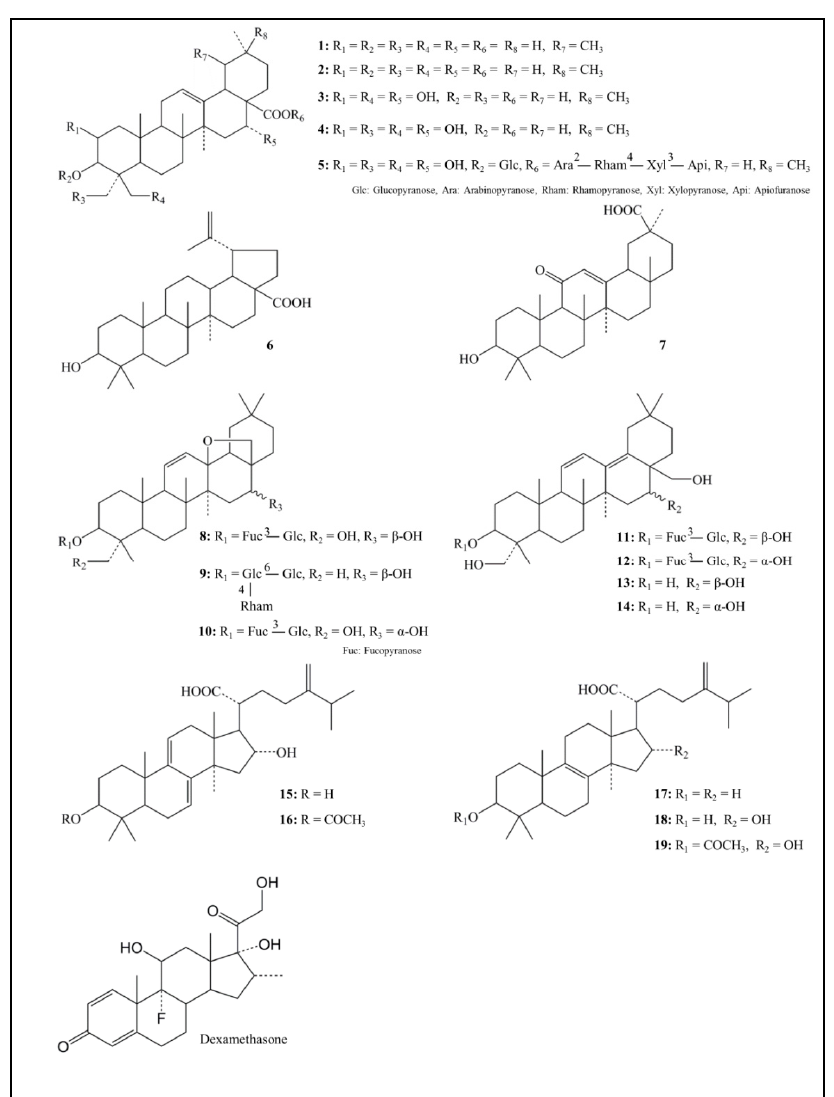
Figure 1. Chemical structure of 19 triterpenoids. 1 : Ursolic acid; 2 : Oleanolic acid; 3 : Polygalacic